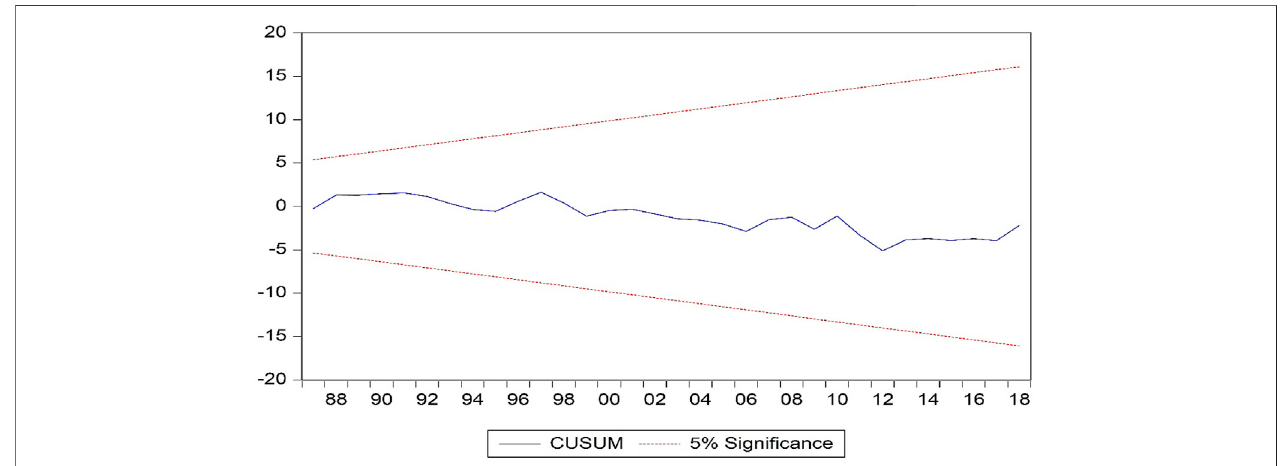
FIGURE 7 | CUSUM plot (model